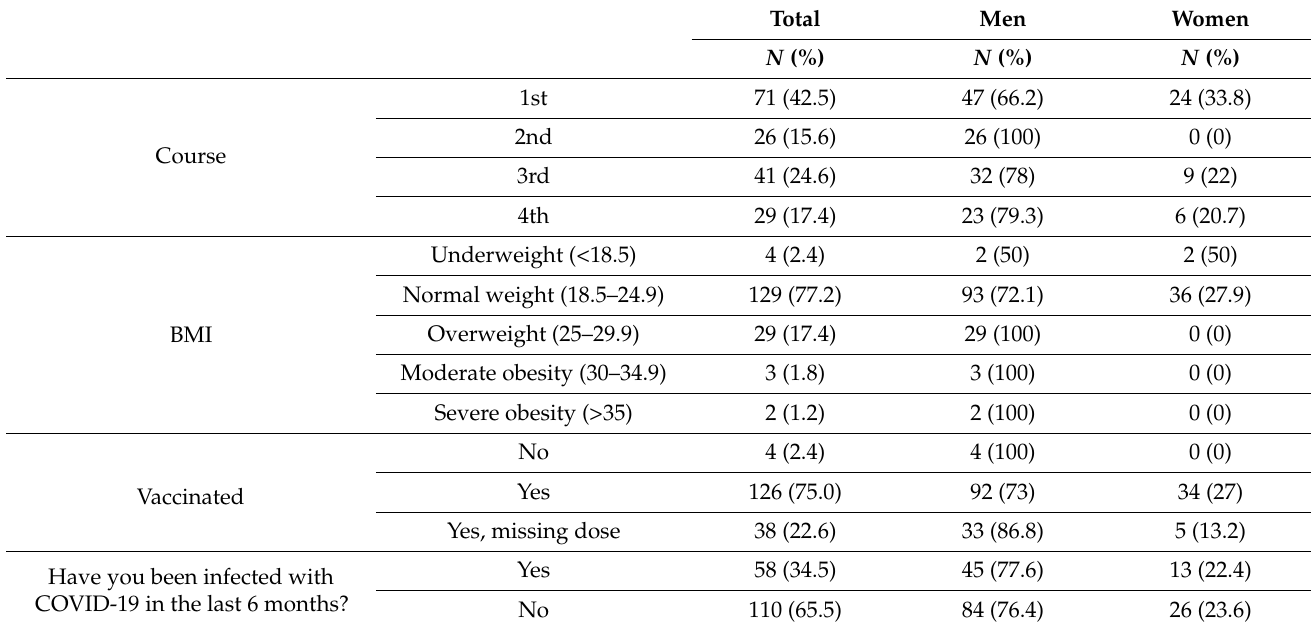
Table 1. Descriptive statistics.